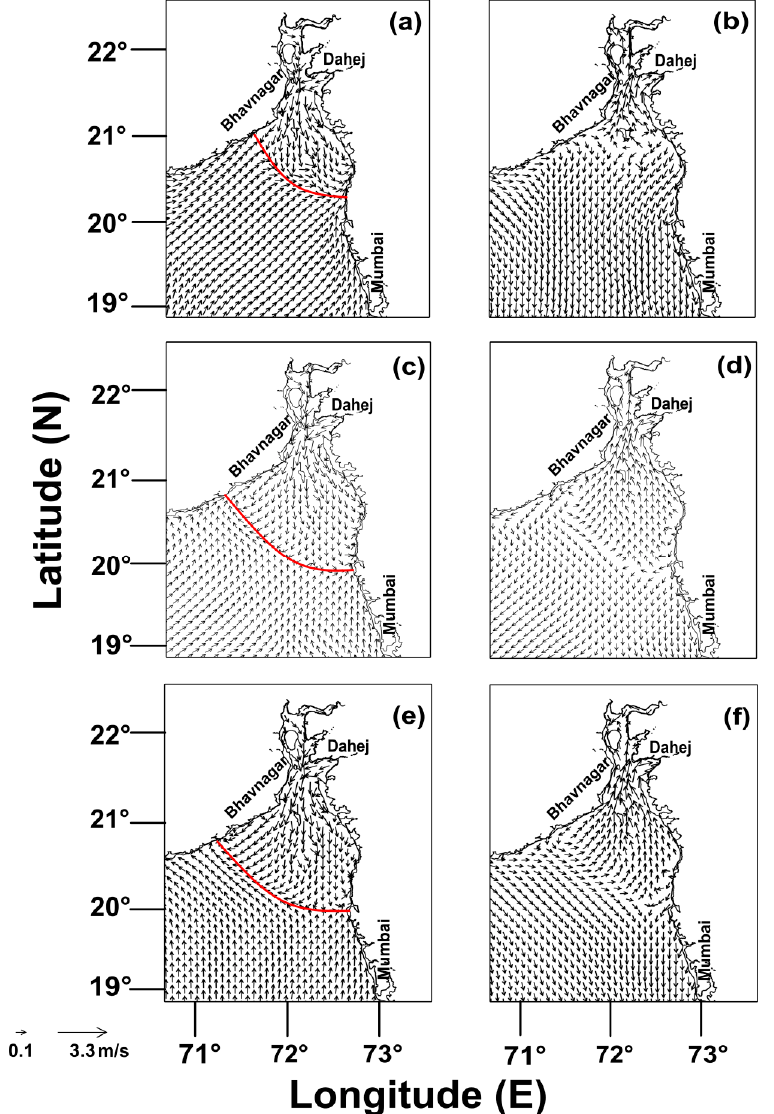
Figure 6. Circulation driven by combined action of tide and wind for various seasons under neap tidal conditions: ( a ) neap ebb for NE-monsoon, ( b ) neap flood for NE-monsoon, ( c ) neap ebb for pre-monsoon, ( d ) neap flood for pre-monsoon, ( e ) neap ebb for SW-monsoon, ( f ) neap flood for SW-monsoon; red line denotes the barrier.